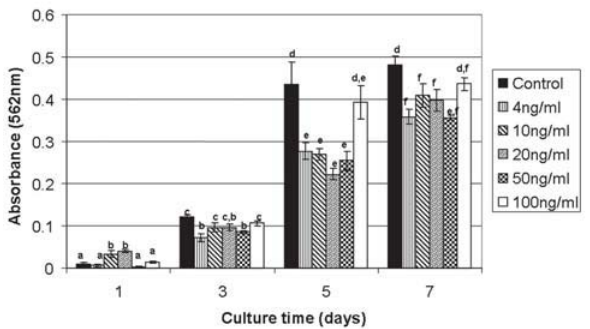
FIGURE 6- Cell viability (absorbance) of osteo-1 cells treated with different concentrations of OP-1 only on the first day of the experiment and cells incubated without OP-1, the medium being changed every 2 days, after 1, 3, 5 and 7 days of culture. Data are reported as the mean ± standard deviation of one experiment performed in